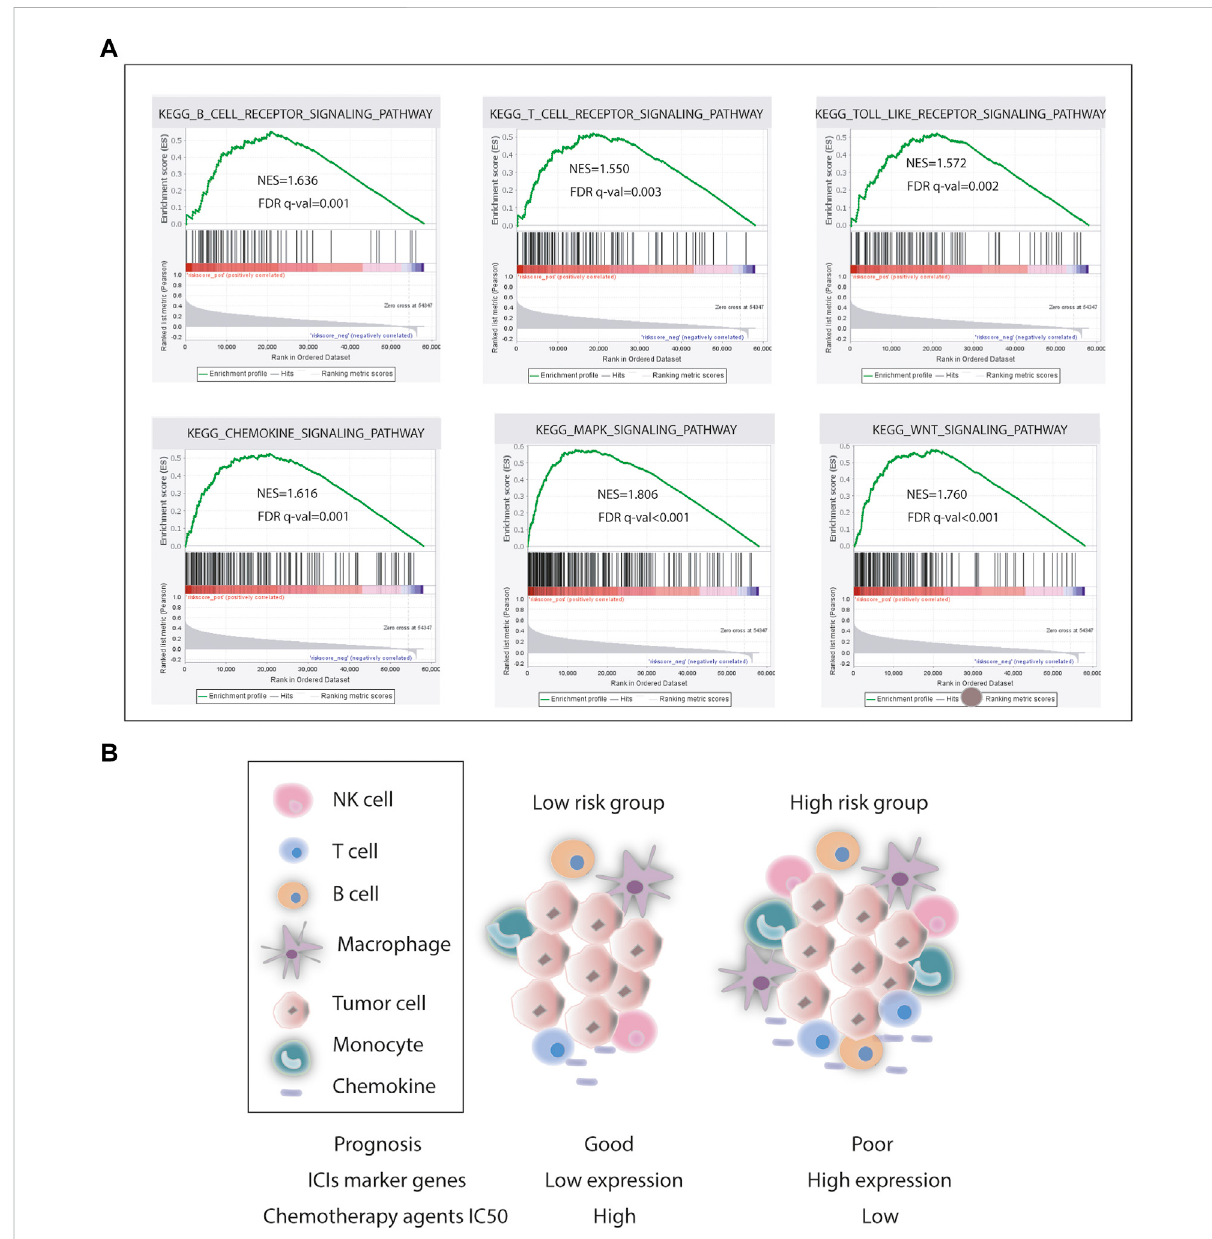
FIGURE 8 Pathway enrichment analysis. (A) Representative pathway enrichment involved in immunity and cancer development. (B) Our association analysis of survival, ICI gene expression, chemotherapy agents IC50, and tumor microenvironment in the low- and high-risk groups.